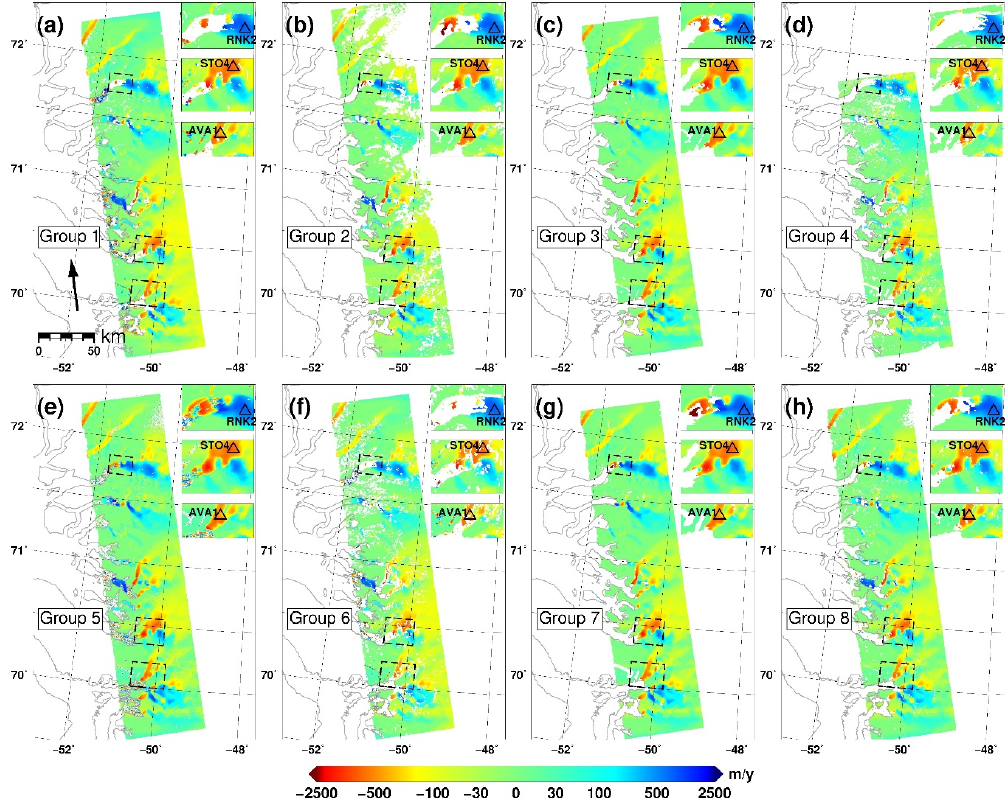
Figure 16. Task 4 azimuth velocity maps provided by groups 1 to 8 ( a – h ). Positive values correspond to motion along the satellite flight path, the ground projection of which is shown by the arrow in ( a